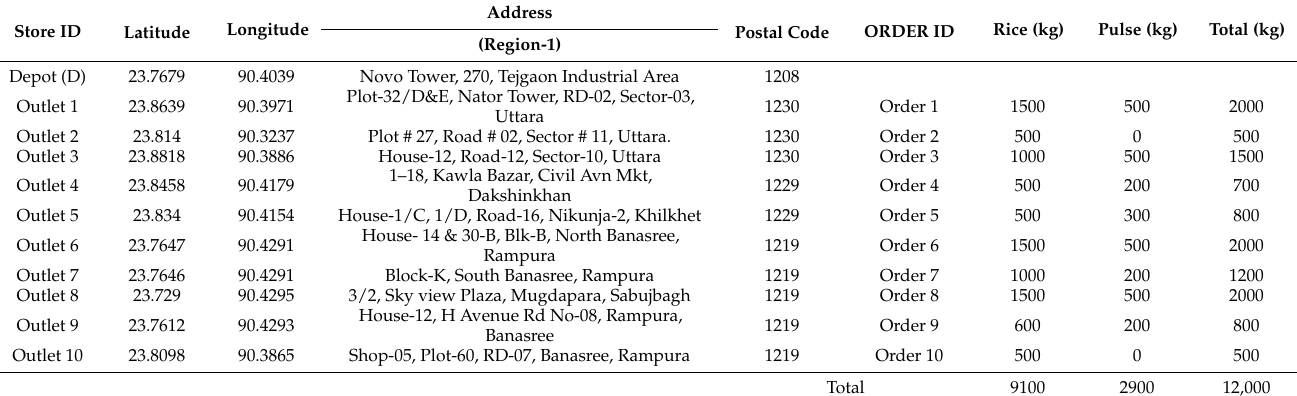
Figure 3. Daily demand of 87 stores for two different commodities of rice and pulse. Table 1. Depot (Warehouse) and Delivery Locations (Outlet) information in Region-1 for assignment of vehicles 1 and